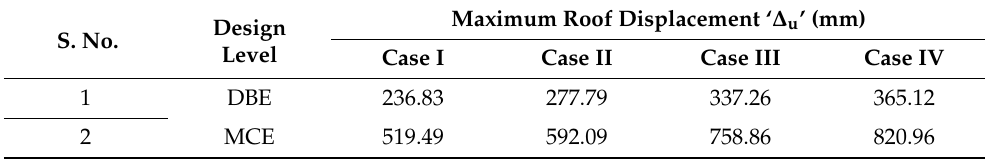
Table 5. Maximum roof displacement under bidirectional